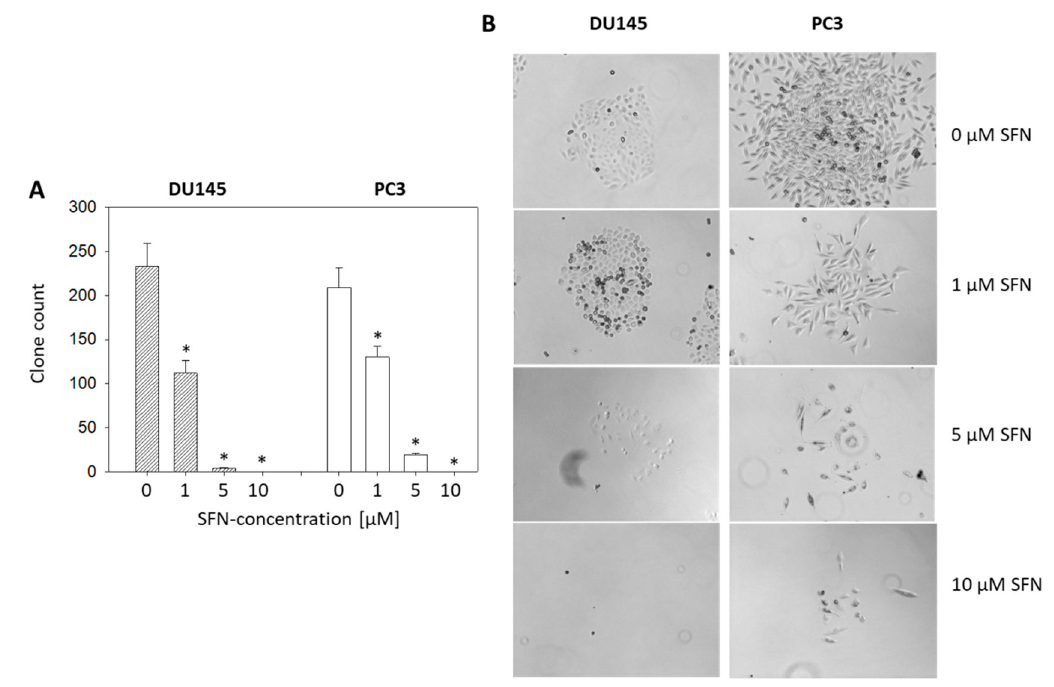
Figure 2. ( A ) Influence of 1, 5, and 10 µM sulforaphane (SFN; 10 day exposure) on clonogenic growth. Whiskers indicate standard deviation. * Indicates significant difference to untreated controls, p ≤ 0.05. n = 3. ( B ) Morphologic alteration after SFN exposure.